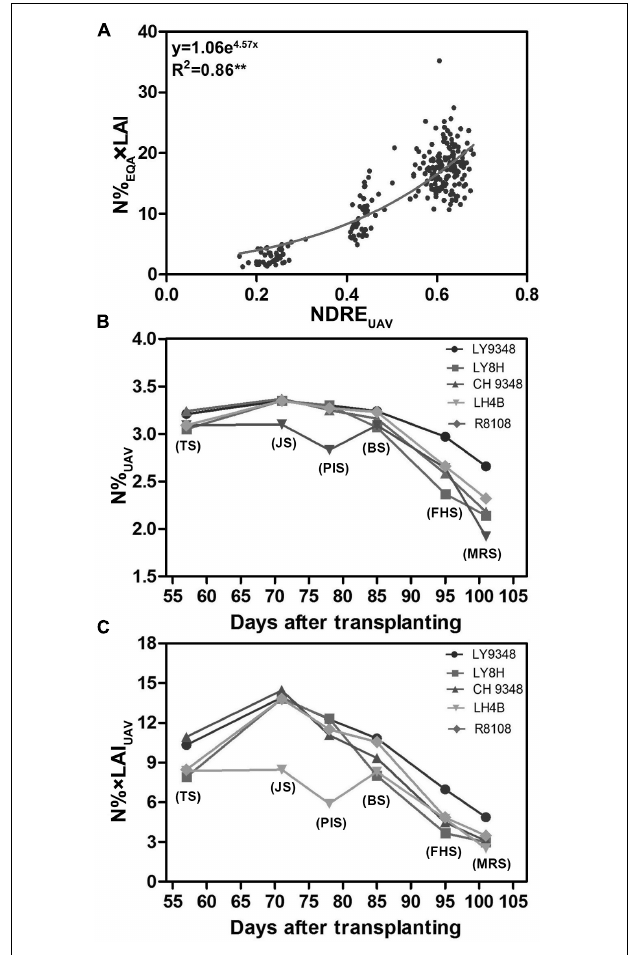
FIGURE 7 | Model II was constructed from 42 rice varieties, and comparisons were performed between Models I and II for nitrogen (N) estimation in LY9348. (A) Non-linear regression model constructed between N% EQA × LAI and NDRE UAV during the entire growth period based on the UAV-RSP ( R 2 = 0.86, n = 252; ** P < 0.01); (B) N% based on UAV data (N% UAV ) estimated by Model I ( y = 5.75 2 + 8.17x + 0.58, x : NDRE UAV ; y : N% UAV ); (C) N% × LAI based on UAV data (N% × LAI UAV ) estimated by Model II ( y = 1.06e 4 . 57x , x : NDRE UAV ; y : N% × LAI UAV ). Each data point in (B,C) are the six developmental stages (TS, JS, PIS, BS, FHS, and